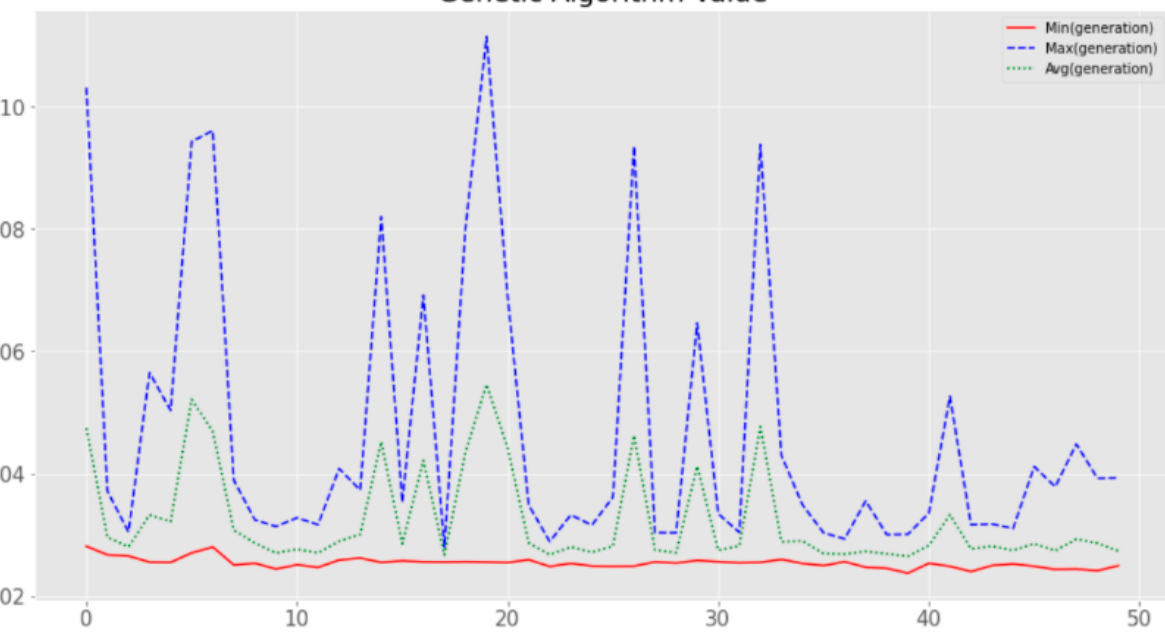
Figure 6. Visualized evaluation functions for each generation: RNN model.